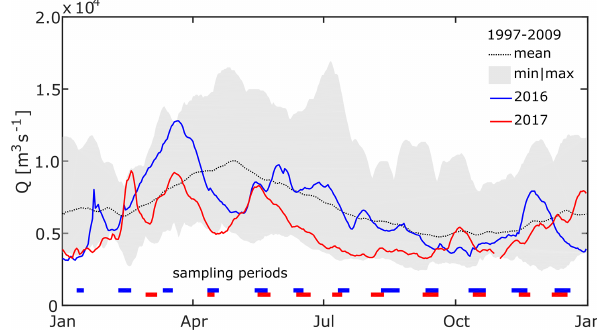
Figure 2. Daily average discharge close to the apex of the Danube Delta. The dotted line and the shaded area show mean and minimum to maximum daily discharge, respectively, for the period from Jan- uary 1997 to October 2009 at Reni, Ukraine (ICPDR, 2018). Blue and red lines show daily average discharge at Isaccea, Romania, in 2016 and 2017 (INHGA; Feodorov). Horizontal bars indicate the timing of sampling campaigns. The x axis ticks indicate the 15th day of the respective